Question: What direction does the quantity move in — increasing or decreasing?
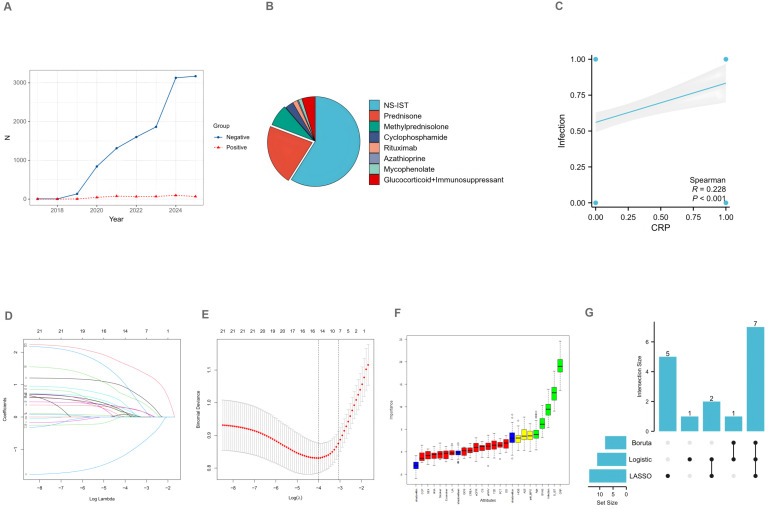
Answer: increasing